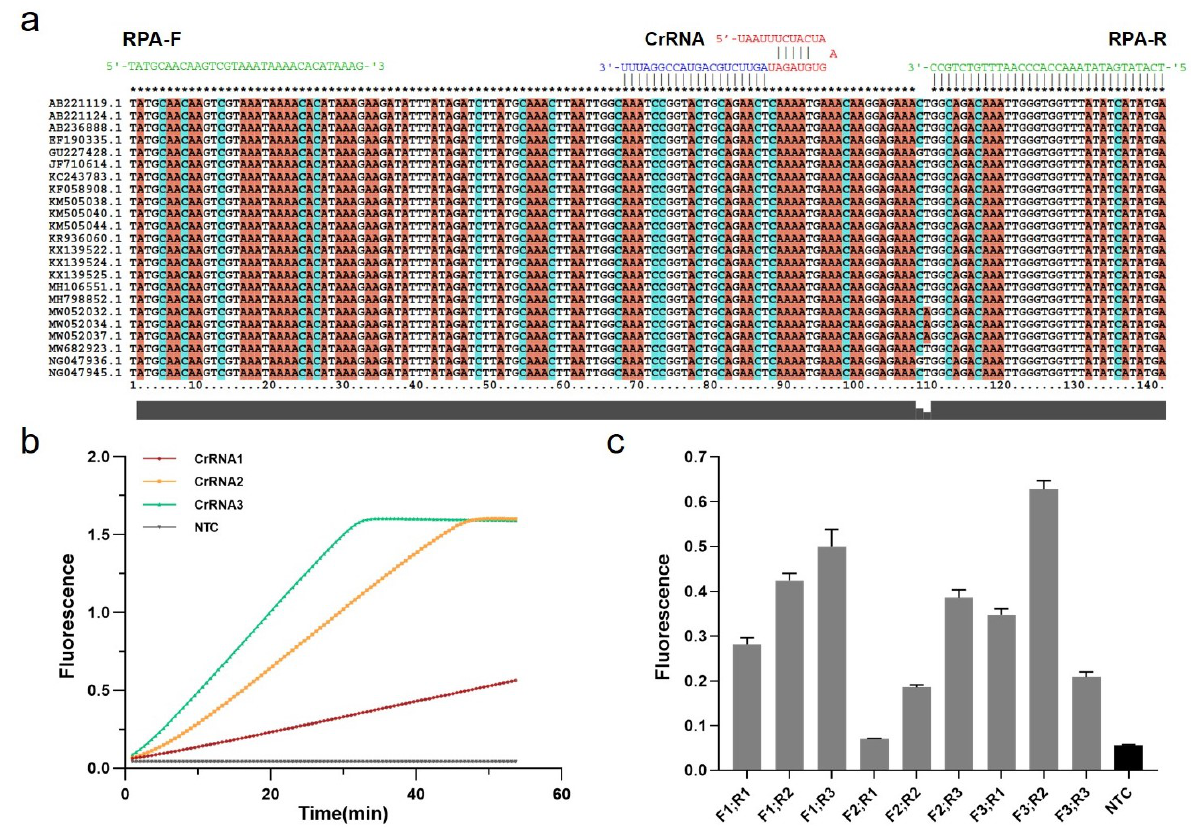
Figure 2. Establishment of RPA-CRISPR/Cas12a system. ( a ) Relatively conserved sequence of mecA gene of MRSA shows target and crRNA sequences on the polymerase coding region. ( b ) Screening for CrRNAs. Real-time fluorescence curves based on PCR-CRISPR/Cas12a on different 3 CrRNAs to detect efficiency. NTC: no template control. ( c ) Screening of RPA primers. Fluorescence values based on RPA-CRISPR detection at different RPA primers. Gray: Postive; Black: